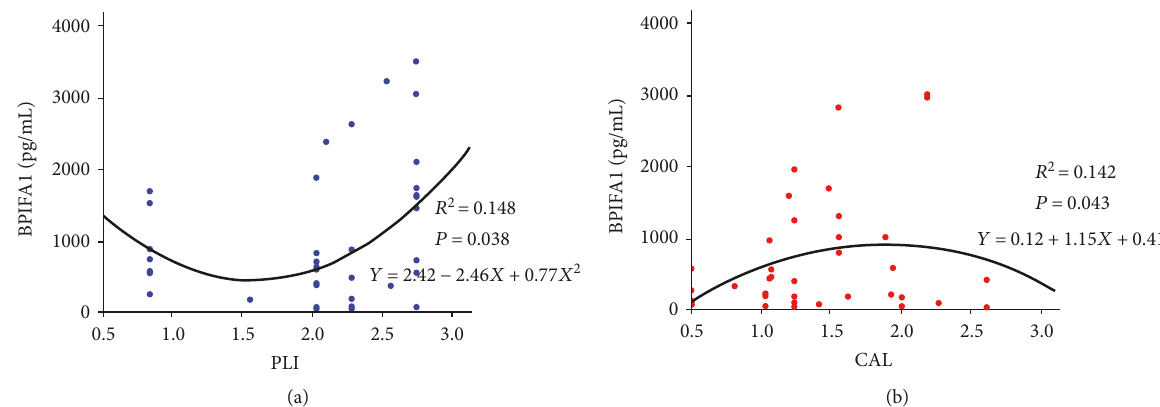
Figure 3: Curve correlation between the concentration of BPIFA1 (pg/mL) and periodontal parameters among individuals with or without T2DM. Blue lines and dots represent NDM subjects, and red lines and dots represent T2DM subjects. Equations and correlation coe ffi cients are shown. As shown in (a), in NDM subjects, PLI and the concentration of salivary BPIFA1 had a statistically signi fi cant relationship in the form of a quadratic term. In T2DM subjects (b), CAL and the concentration of salivary BPIFA1 had a statistically signi fi cant relationship in the form of a quadratic term. Table 6: Logistic regression analysis of salivary BPIFA1, TNF- α , and IL-6 in subjects with or without